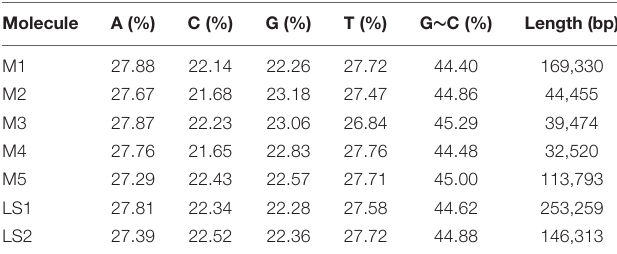
TABLE 2 | Summary of T. esculentum mitochondrial subgenome